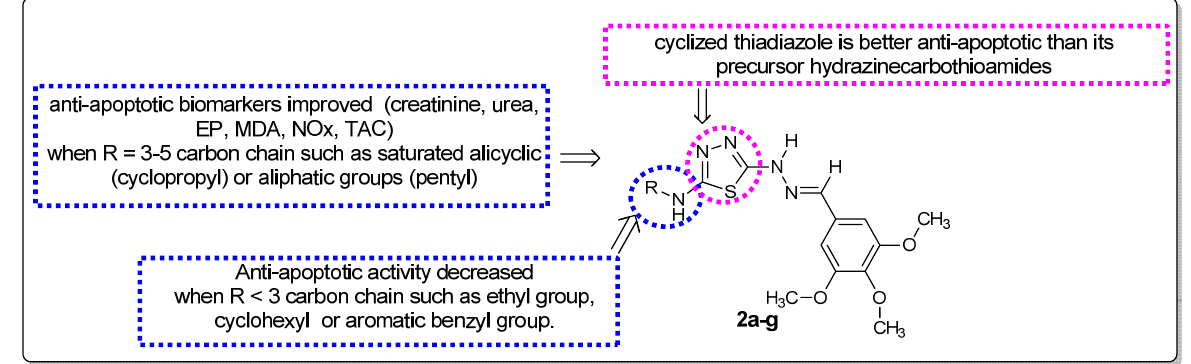
Figure 9. Summary of SAR of cyclized thiadiazole derivatives 2a – g and their corresponding opened hydrazinecarbothioamides 1a – g.